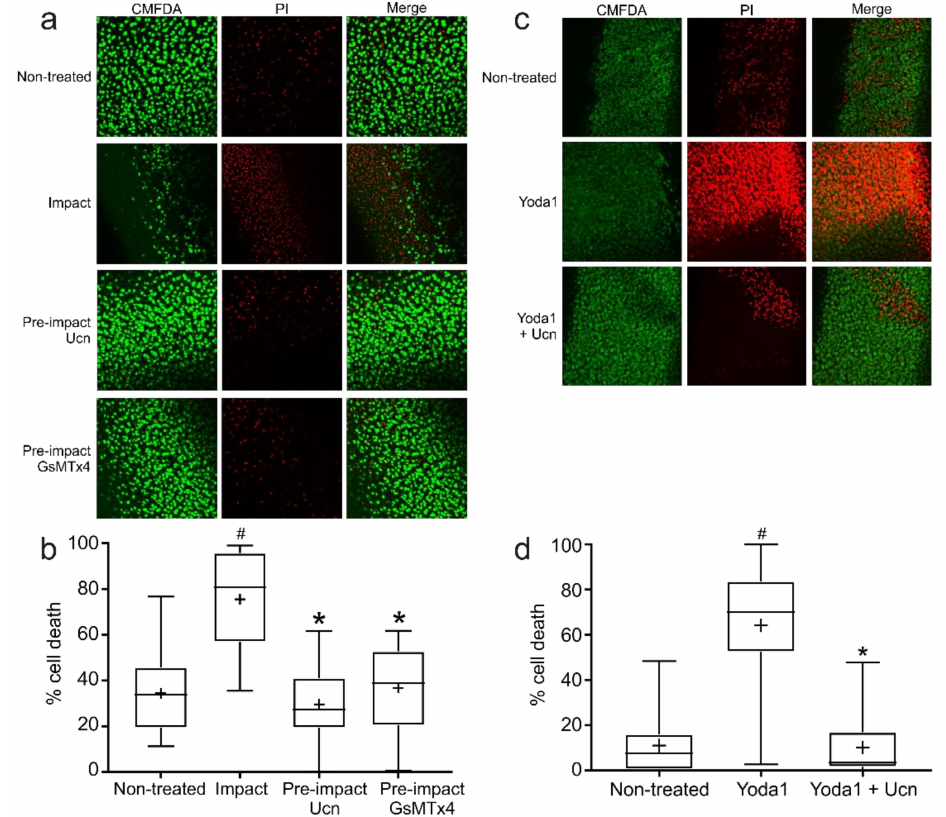
Figure 6. Chondroprotection by Ucn involves the prevention of Ca 2+ overload by Piezo1. ( a ) Representative images of explants 72 h following impact with or without pre-treatment with Ucn or GsMTx4. Live cells stained with CMFDA (green) and dead cells with PI (red). ( b ) Quan- tification of percentage cell death from impact experiments shown in ( a ) ( n = 6 explants, 5 fields of view/explant; # = p < 0.01 vs. non-treated, * = p < 0.01 vs. impact). ( c ) Representative images of explants 72 h after treatment with Yoda1 +/ − Ucn. Live cells stained with CMFDA (green) and dead cells with PI (red). Representative images of n = 6 experiments, 5 fields of view/explant. ( d ) Quantification of percentage cell death from experiments shown in ( c ) ( n = 6 explants, 5 fields of view/explant; # = p < 0.01 vs. non-treated, * = p < 0.01 vs. Yoda